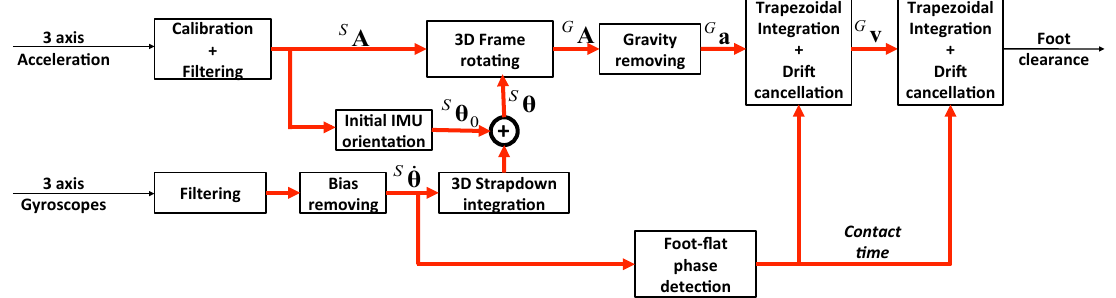
Calibra’on + Filtering